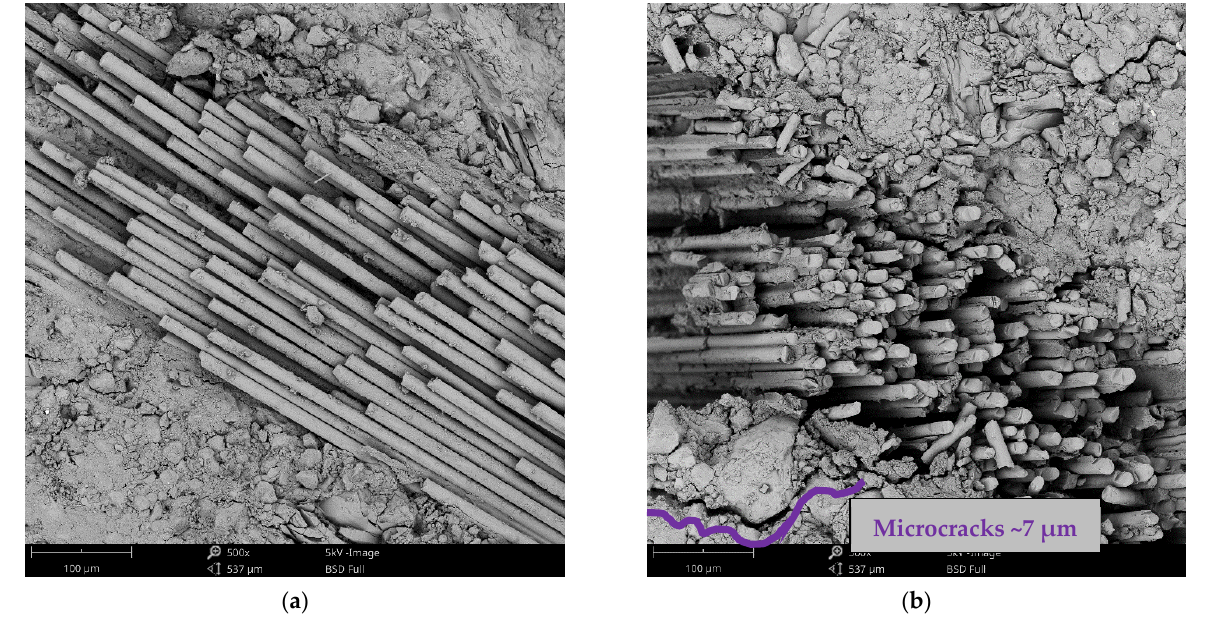
Figure 6. ( a ) The interface between the fiber and the matrix. ( b ) Structure of the material with microcrack-trapping fibers.